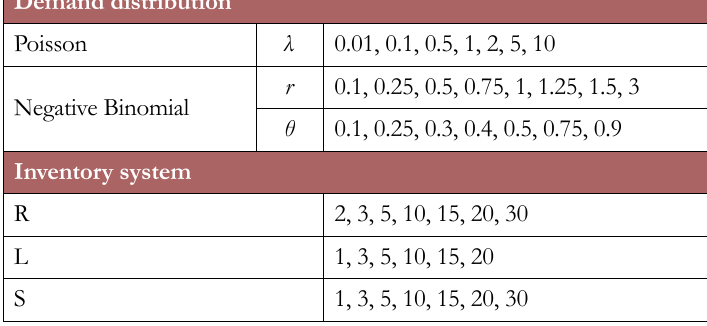
Table 1. Dataset of the